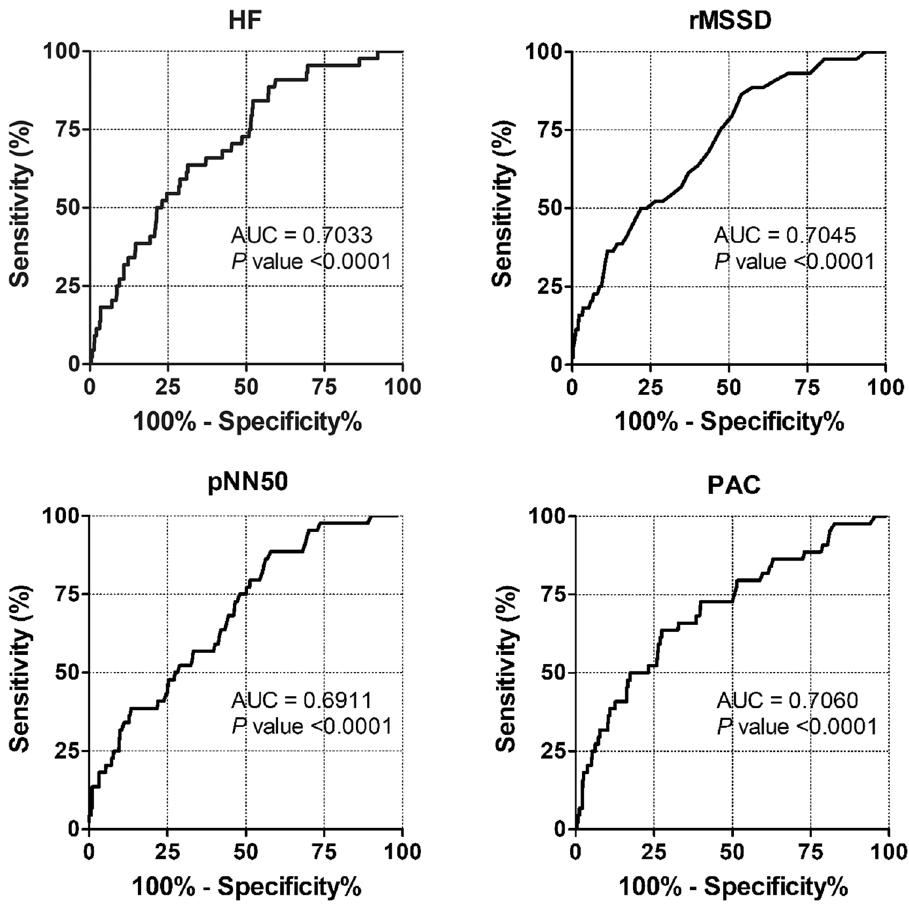
Figure 2. ROC curve of heart rate variability and premature atrial contractions to predict the occurrence of atrial fibrillation. ROC, Receiver operating characteristic; HF, high frequency; rMSSD, square root of the mean squared differences of successive NN interval; pNN50, the percentage of RR intervals more than 50 ms different from the previous interval; PAC, premature atrial contraction; AUC, area under the curve.